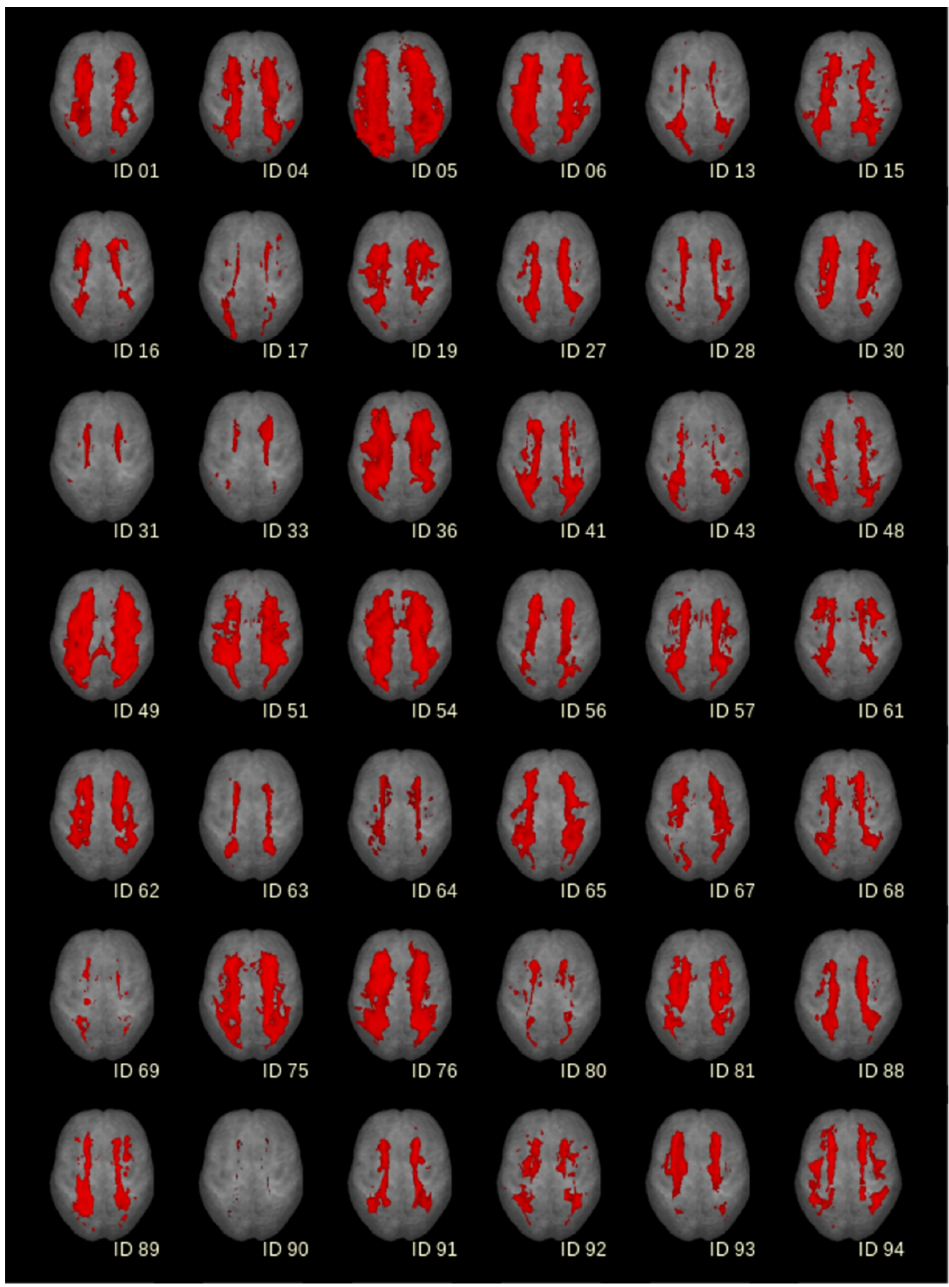
Figure 1. White matter hyperintensities (WMH) for 42 patients detected from FLAIR-MRI recordings in axial projection views. For comparability, individual results were normalised to the Montreal Neurological Institute (MNI) coordinate frame and displayed on the same morphological background (segmented averaged